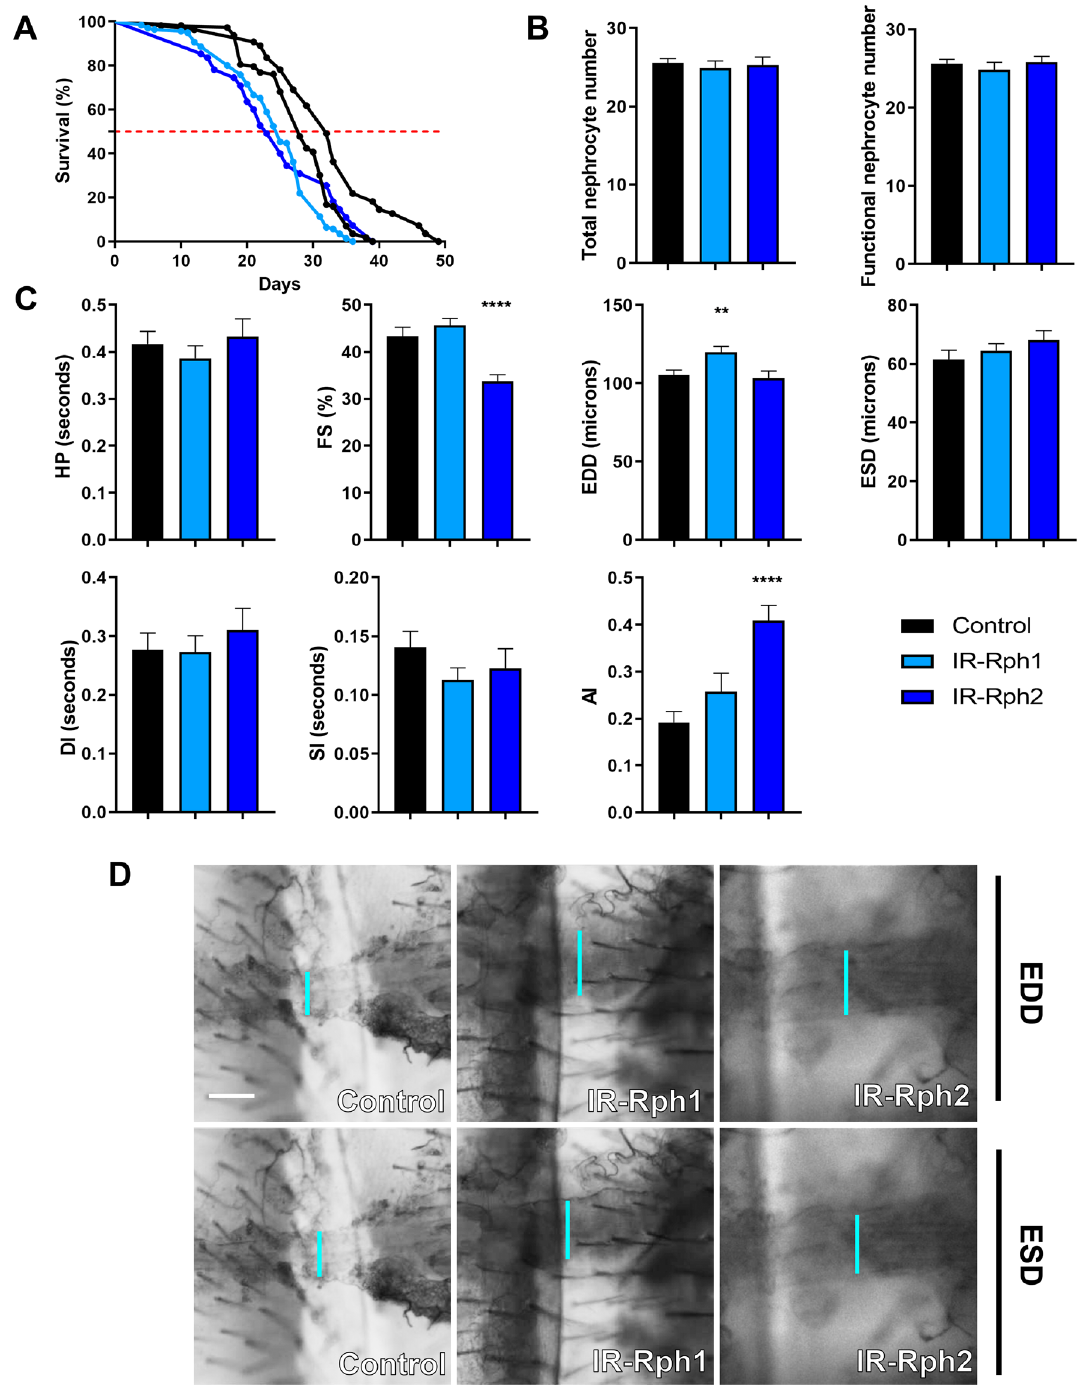
Figure 6. Rph RNA interference expression in pericardial nephrocytes produces a slight extension of the diastolic diameter in the adult Drosophila heart. ( A ) Survival curves of control ( Sns-Gal4 UAS-GFP > UAS-IR-bcd and Sns-Gal4 UAS-GFP > yw black lines) and Rph RNAi knockdown (blue lines) flies under the control of the Sns-Gal4 driver. ( A ) The Rph silencing in nephrocytes impaired survival of adult IR-Rph flies. The horizontal red line marks the median survival. ( B ) Average number of total and functional pericardial nephrocytes in 1-week-old control ( Sns-Gal4 UAS-GFP > UAS-IR-bcd) and IR-Rph flies ( Sns-Gal4 UAS-GFP > UAS-IR-Rph) . ( C ) Adult heart function parameters represented as column bar graphs. ( D ) Representative micrographs of dissected fly abdomens showing heart tubes in the diastolic and systolic phases. Blue lines mark the distance between the heart walls in diastole and systole phases (EDD and ESD, respectively). The genotype of the control flies in C , D is Sns-Gal4 UAS-GFP > yw. Scale bar = 60 µm. Statistics results: log-rank (Mantel–Cox) test for survival: p value < 0.0001. Student’s t-test. ** p value < 0.01, **** p value <